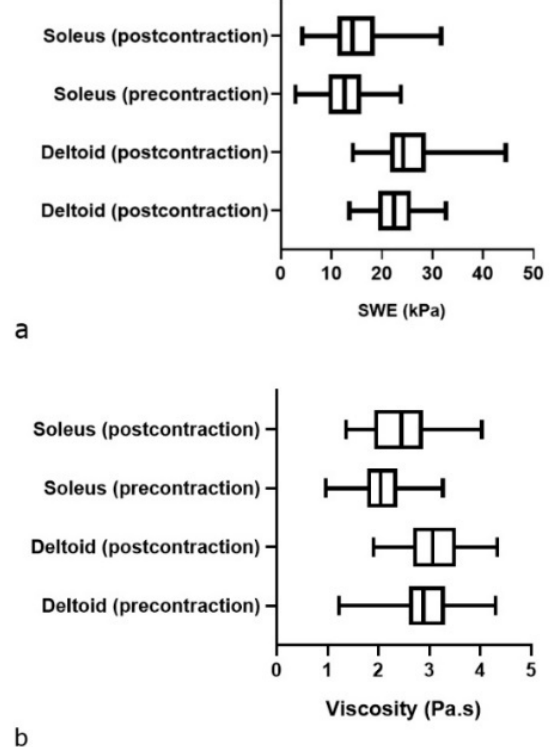
Figure 5. Boxplot showing the tissue elasticity ( a ) and viscosity ( b ) of the deltoid and soleus muscles measured in the longitudinal plane before and after contraction. p < 0.05, a significant difference between the two sets of measurements.